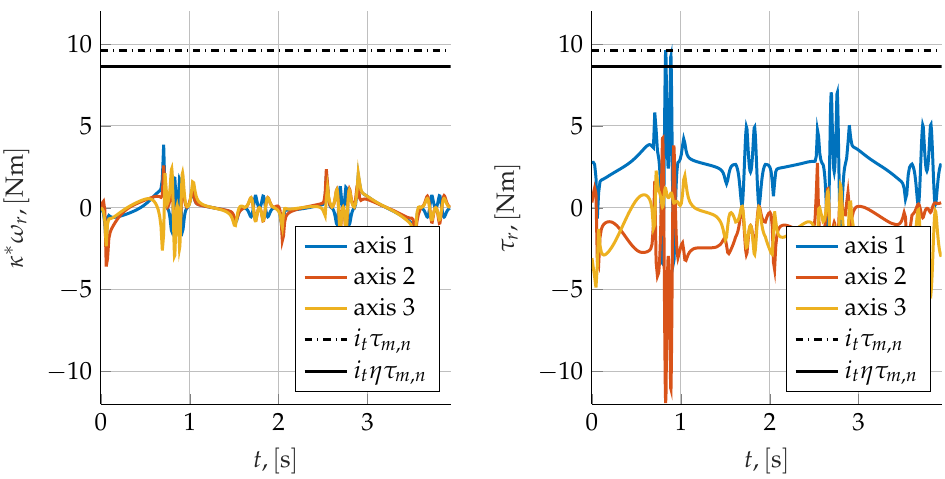
Figure 22. Torques at the output shaft for i t = 12; in the left panel : inertial torques of the motor projected through an ideal transmission; in the right panel the load torques are reported. The black lines represent the rated torque of the motor reduced to the output shaft through an ideal (dashed line) and non-ideal (continuous line)